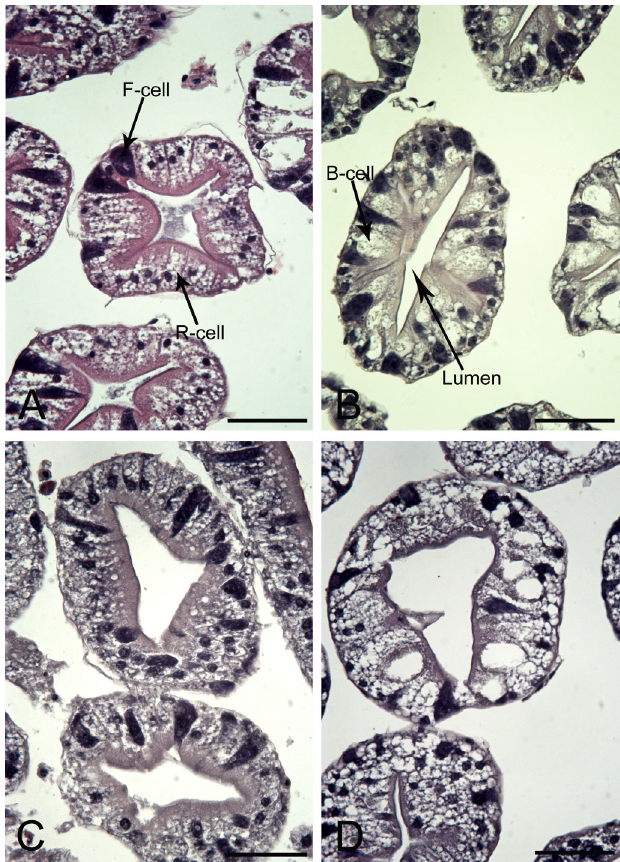
Fig. 2. (A, B) March sampling. Digestive glands tubule from male (A) and female (B) N. norvegicus. (C, D) May sampling. Digestive glands tubule from male (A) and female (B) N. norvegicus. Scale bar= 5.5 m m.